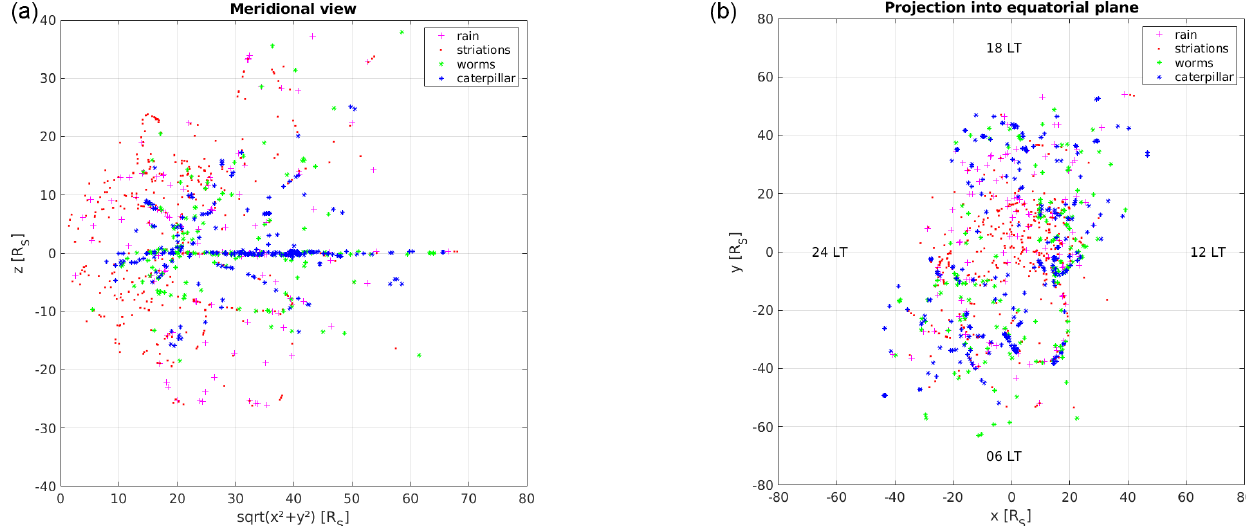
Figure 8. Meridional (a) and equatorial distribution (b) of Cassini positions from where SKR of the SPEC class (rain, striations, worms, caterpillars) was observed below